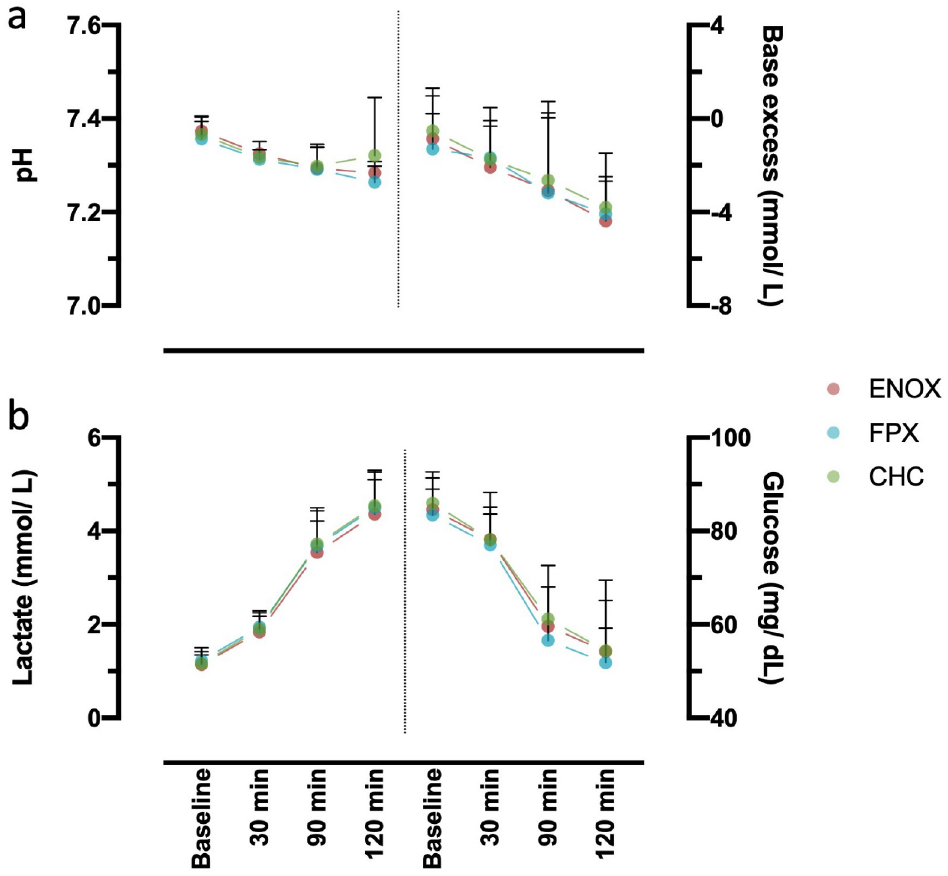
Fig 3. Comparison of the acid-base status and glucose metabolism after 30, 90, 120 minutes of incubation. Blood samples were incubated for 30, 90 or 120 minutes at 37˚C using the MPC-based coating protocol with either ENOX or FPX as anticoagulant or the CHC-coating protocol. Base excess and pH (a) as well as lactate and glucose (b) were measured via blood gas analysis. No differences among the models were observed at any of the investigated timepoints. Data was considered exploratory and for further reference, therefore no statistical testing was performed. Values are presented as mean + 95% CI. All samples: n =